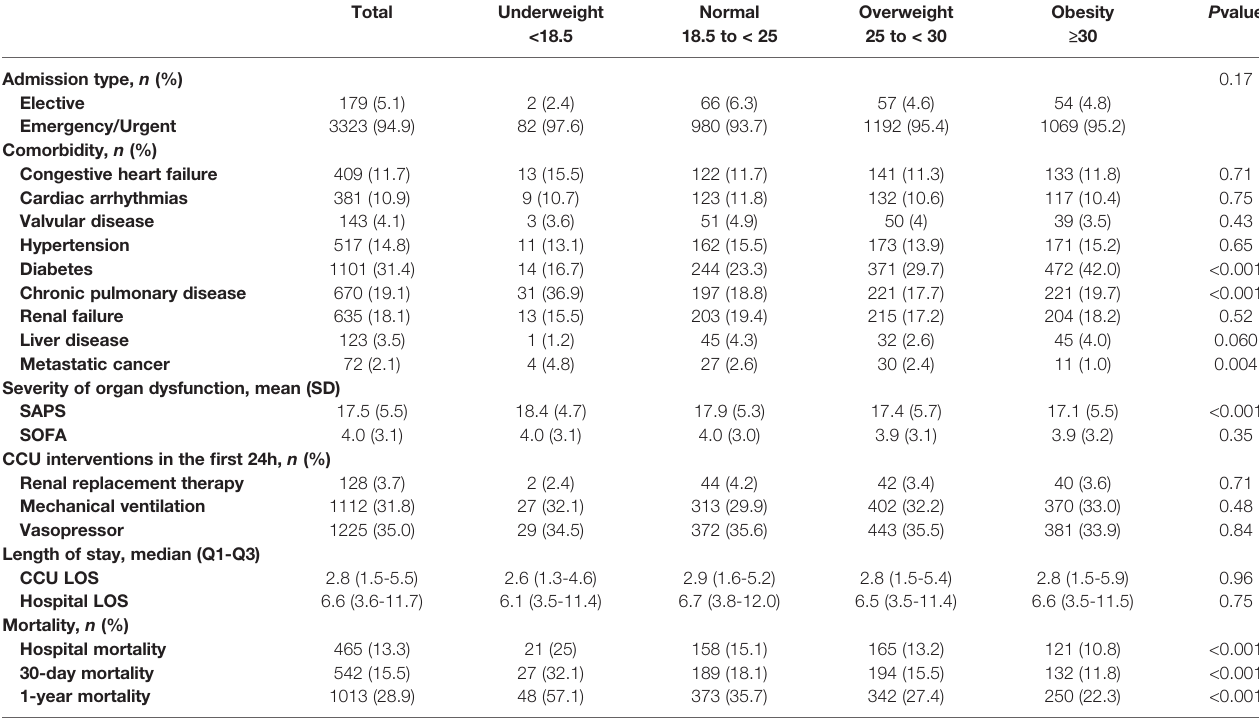
TABLE 2 | Univariate analysis of hospitalization characteristics by BMI category.